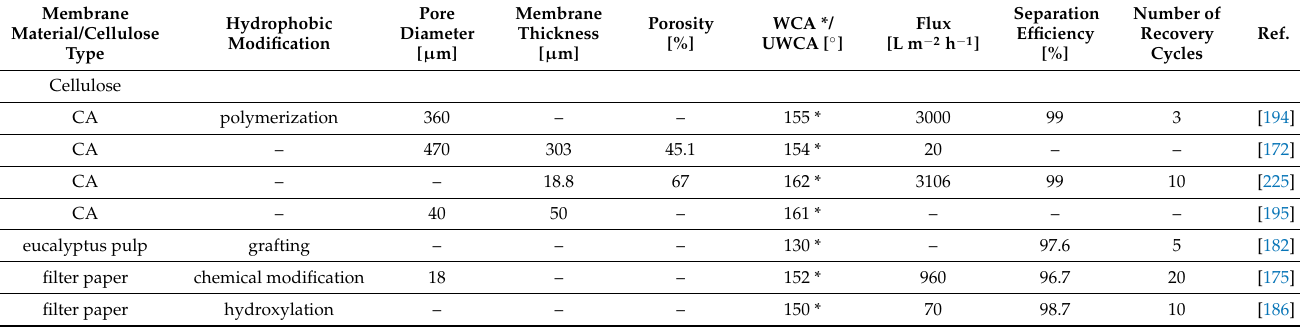
Table 6. Cellulose based membranes for oil removal (values are marked with * if it is the WCA; otherwise the UWCA is